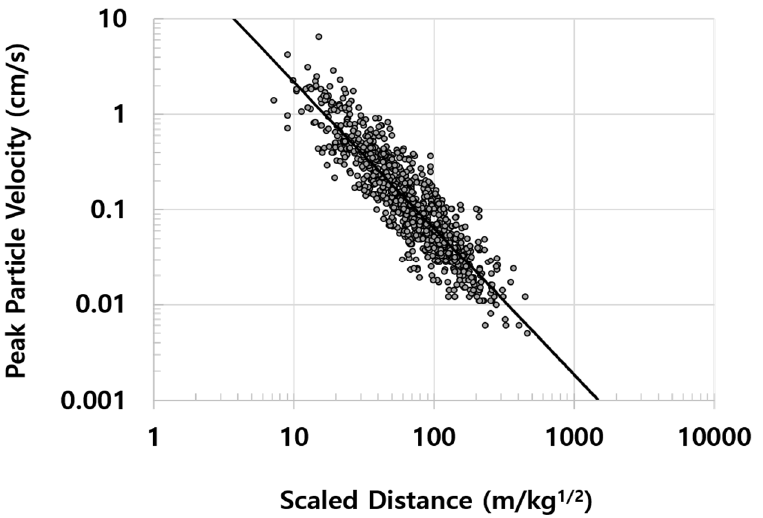
Figure 5. Peak particle velocity versus scaled distance for 893 datasets.